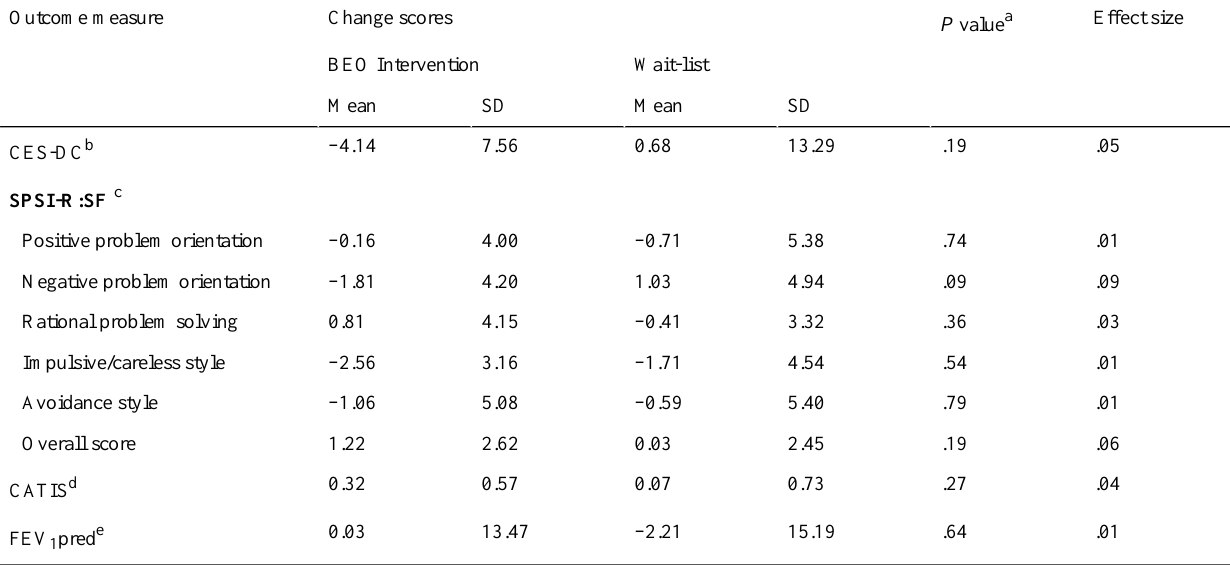
Table 3. Descriptive statistics on change scores (time 1 to time 2 differences) of outcome measures for children and adolescents for Breathe Easier Online (BEO) intervention and wait-list control